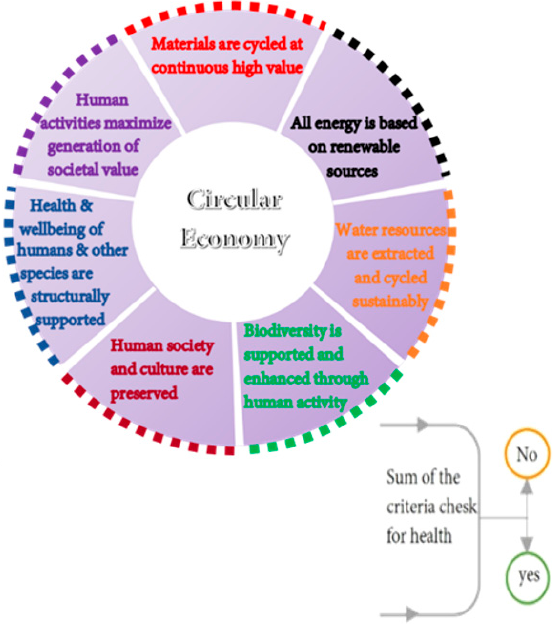
Figure 8. Schematic demonstration of 7 pillars of CE.